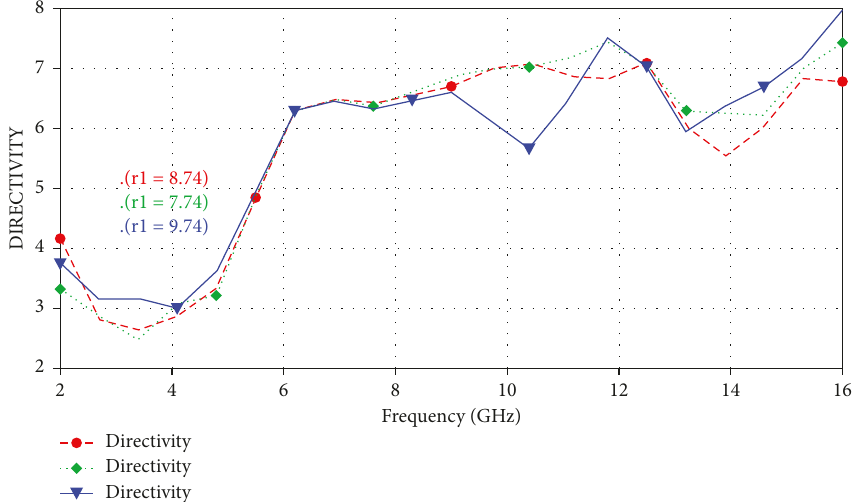
Figure 10: Directivity vs. frequency